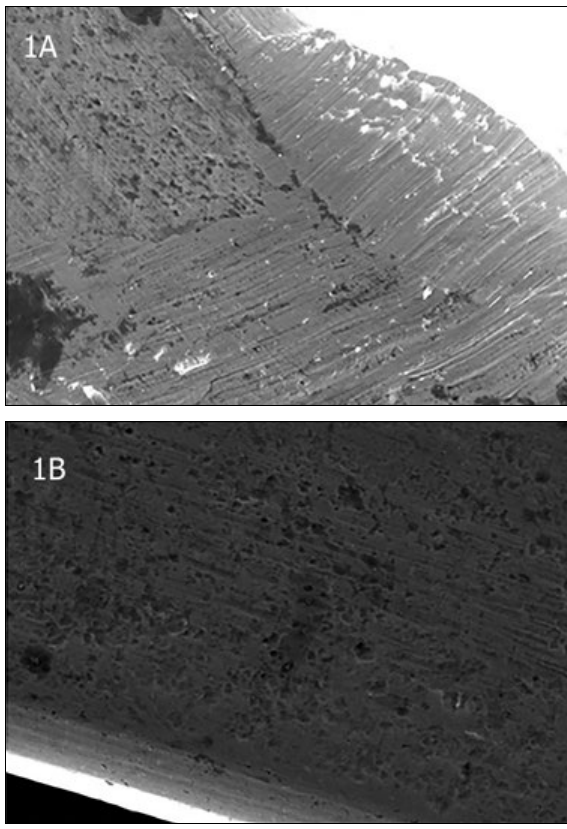
Figure 1. Representative topographic SEM images of archwires’ surfaces after canine sliding.